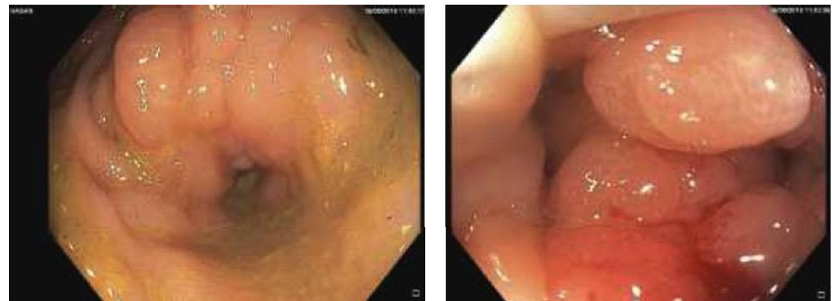
Figure 1: Colonoscopy fi ndings of stenotic rectal mass.